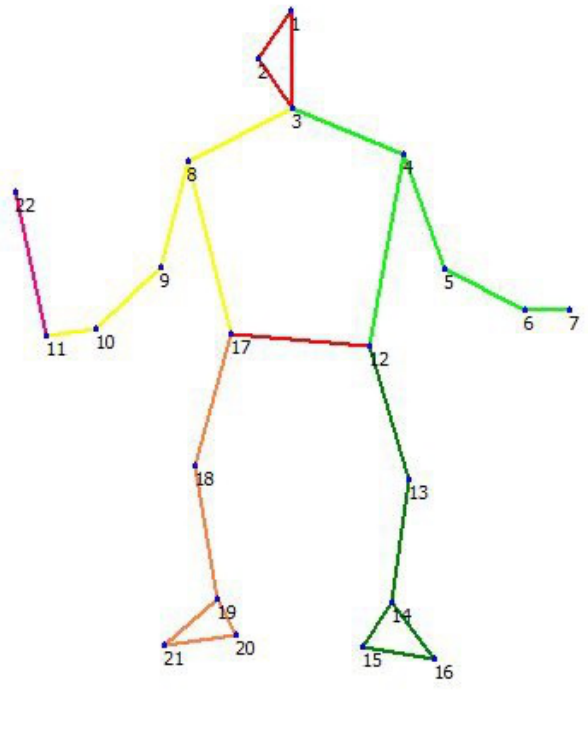
Fig. 1 Black point human joint model of Matsui